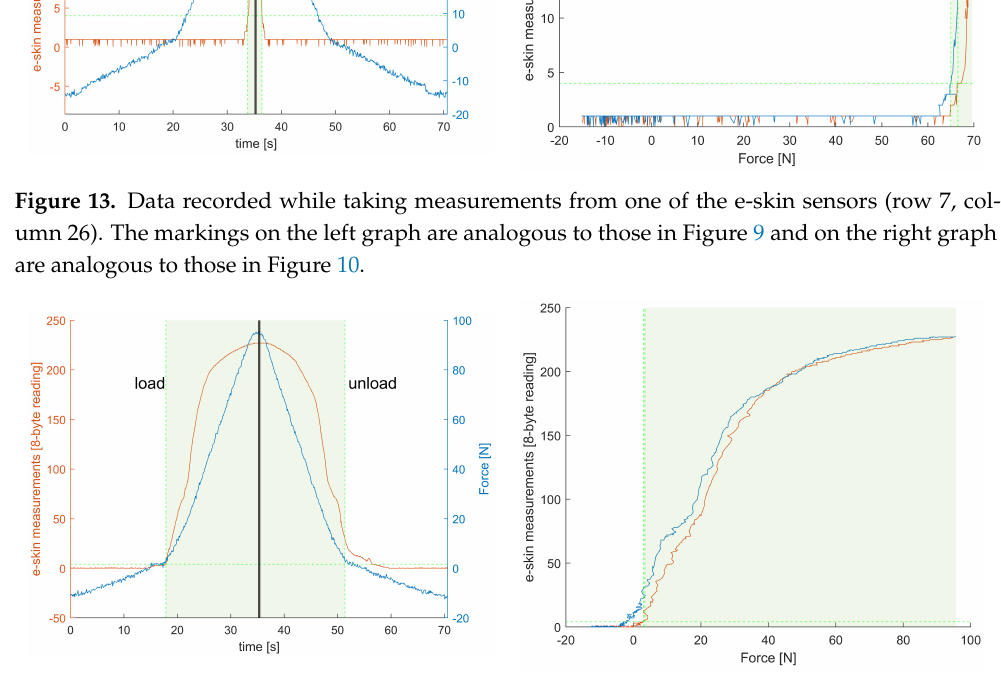
Figure 14. Data recorded while taking measurements from one of the e-skin sensors (row 16, col- umn 30). The markings on the left graph are analogous to those in Figure 9 and on the right graph are analogous to those in Figure